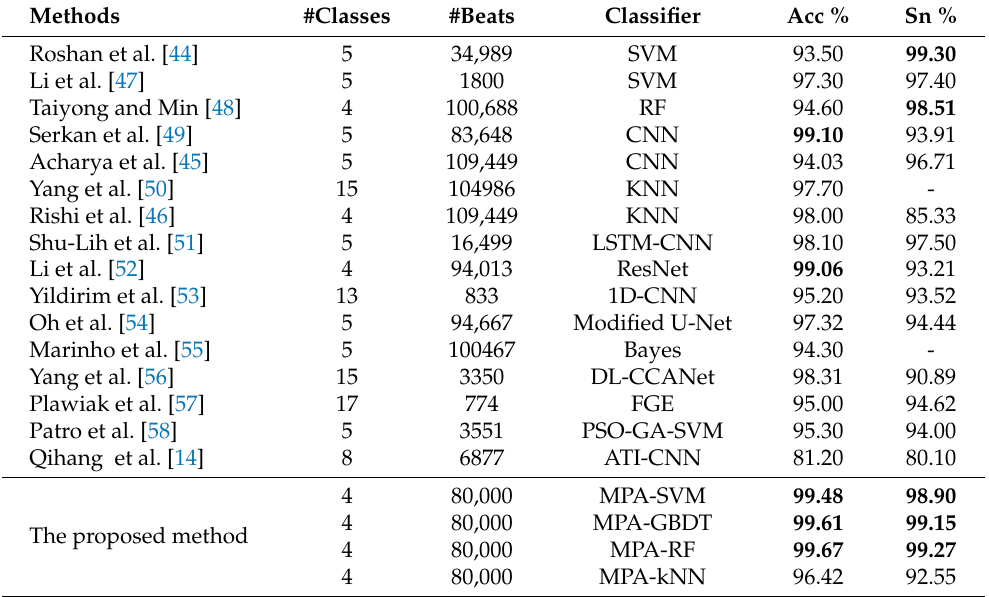
Table 12. Classification performance comparisons between the proposed method and other